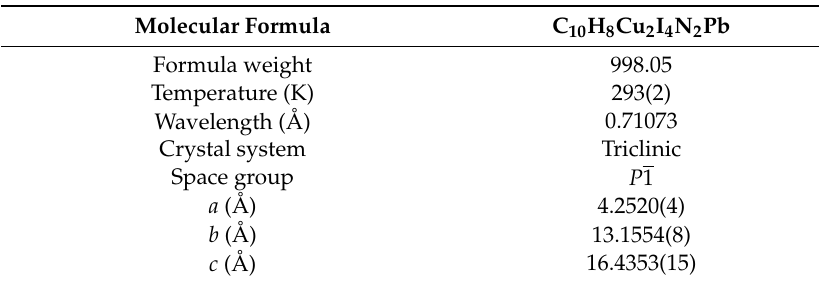
Table 1. Crystallographic data and structure refinement parameters for 1